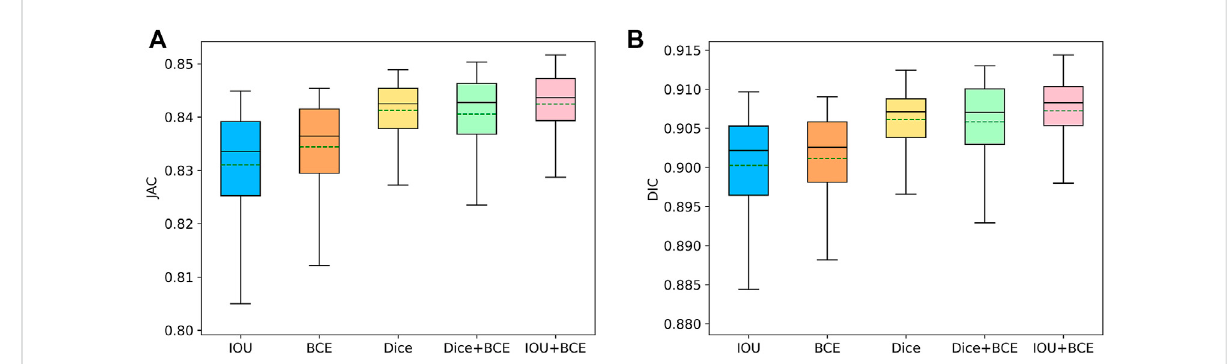
FIGURE 9 Boxplotsofthetypicalmetrics.i.e.,JAC (A) andDIC (B) ,fordifferentlossfunctioninSL-HarDNet.Themeanvalueofeachmetricisrepresented by a green dashed